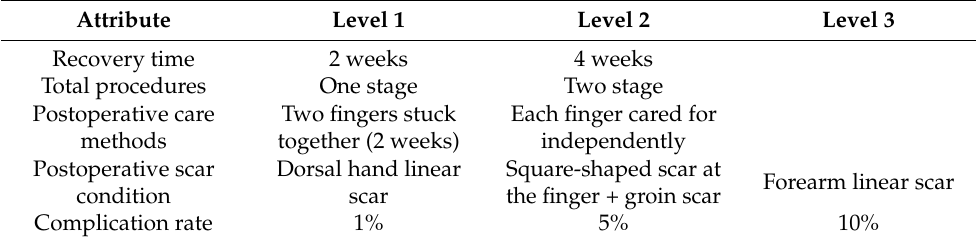
Table 1. Attribute and value levels of finger trauma